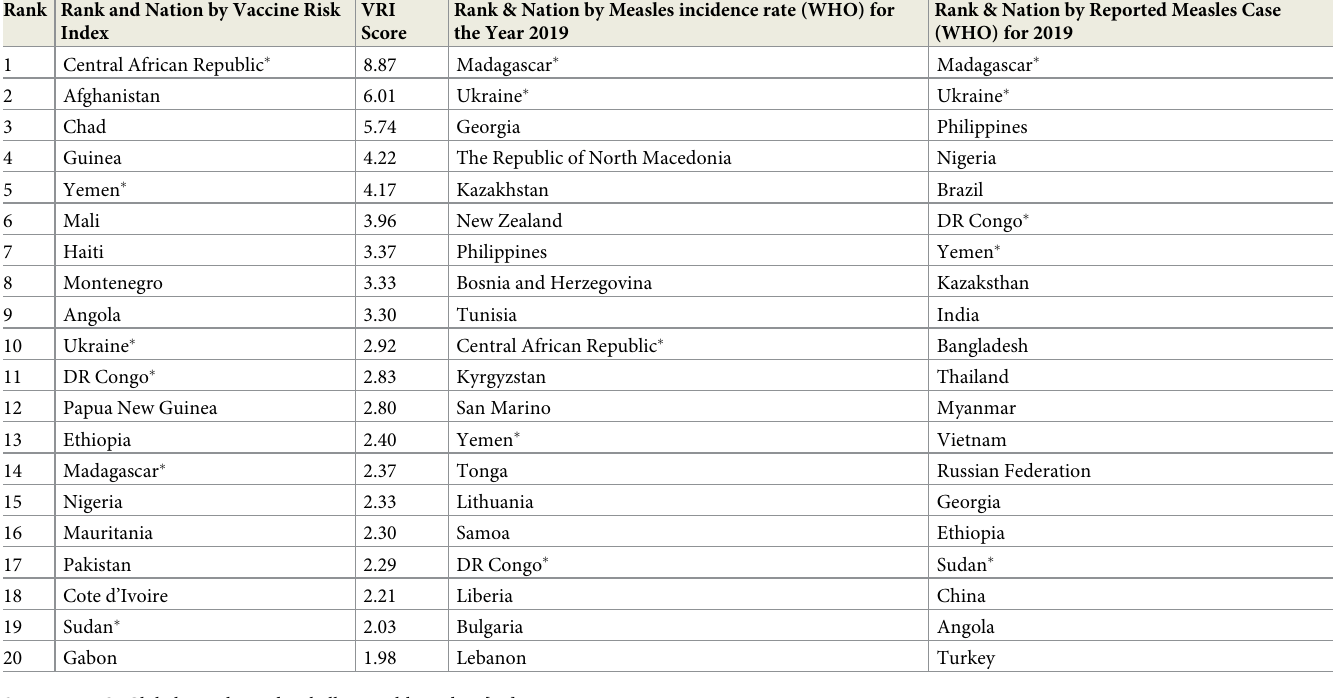
Table 3. Top 20 vaccine risk nations and WHO’s 2019 list of the top 20 most measles endemic nations. Rank Rank and Nation by Vaccine Risk Index